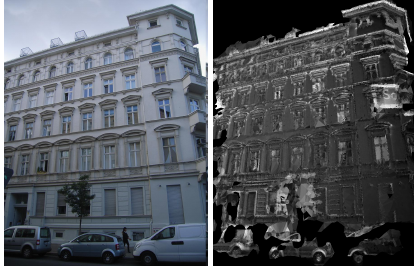
Figure 4. Fac¸ade image and visualization of colour differences to the complete sequence. The street sign showing the two letters ”So” are visible in one image, thus there are big colour differ- ences at that position.